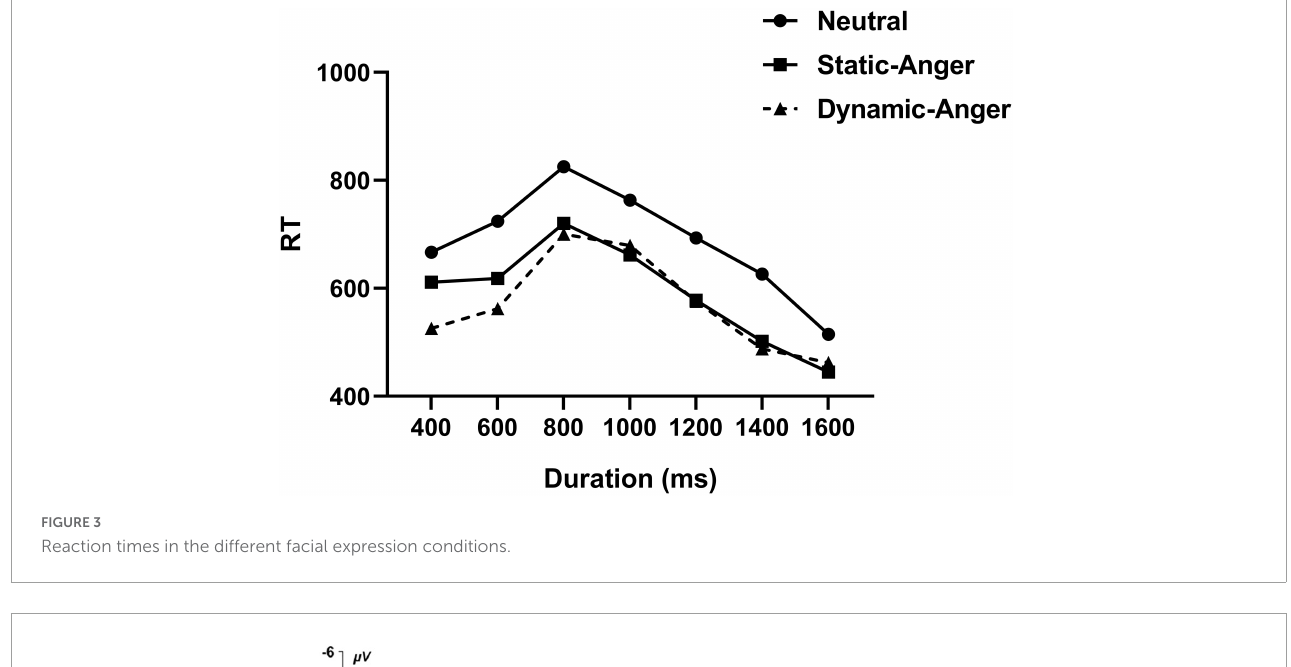
FIGURE3 Reaction times in the different facial expression conditions.